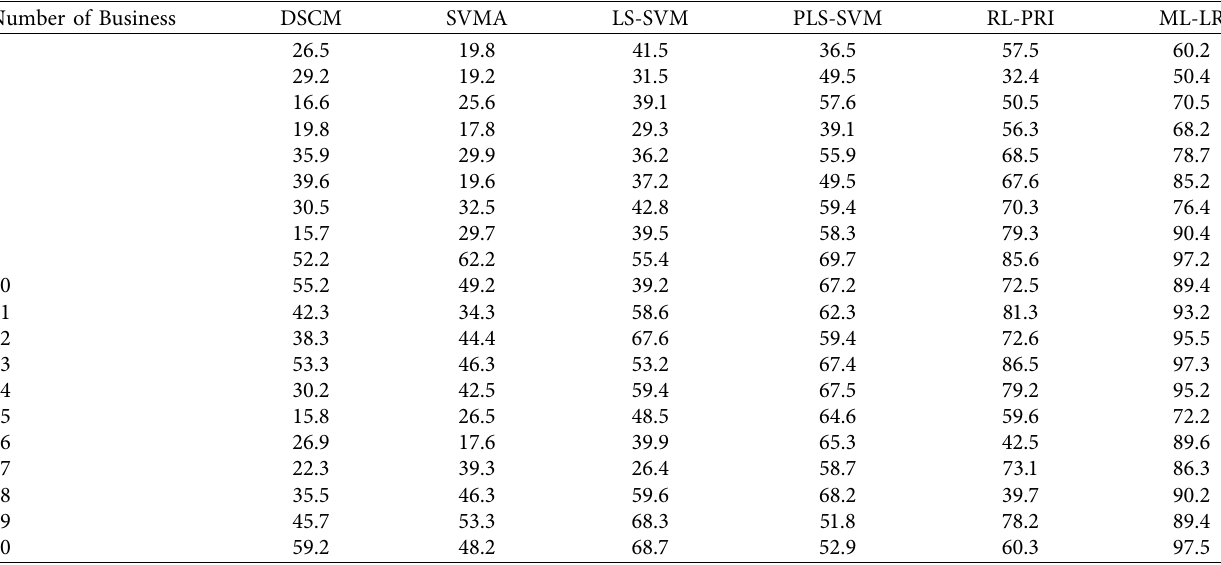
Table 1: Detection of supplier credit risk in financial returns in supply chain.